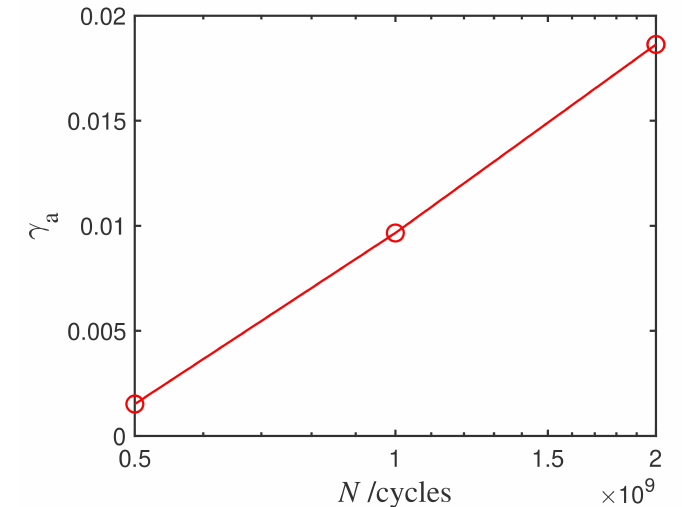
Figure 10. Evolution of accumulated plastic strain as a result of WEB formation with respect to the number of